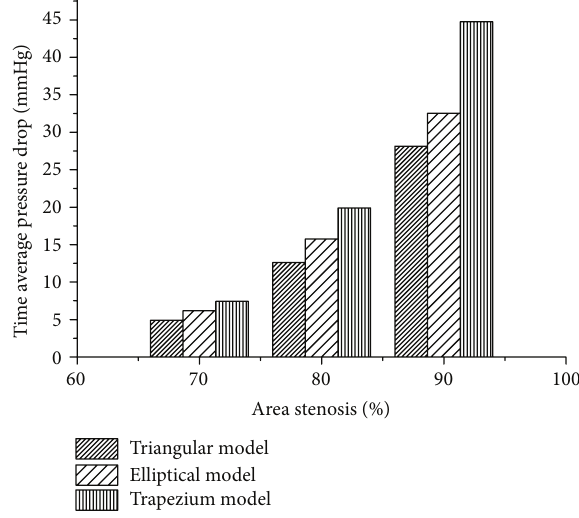
Figure 4: Bar graph showing variation of time averaged pressure drop across a given area stenosis with different shape stenosis (triangular, elliptical, and